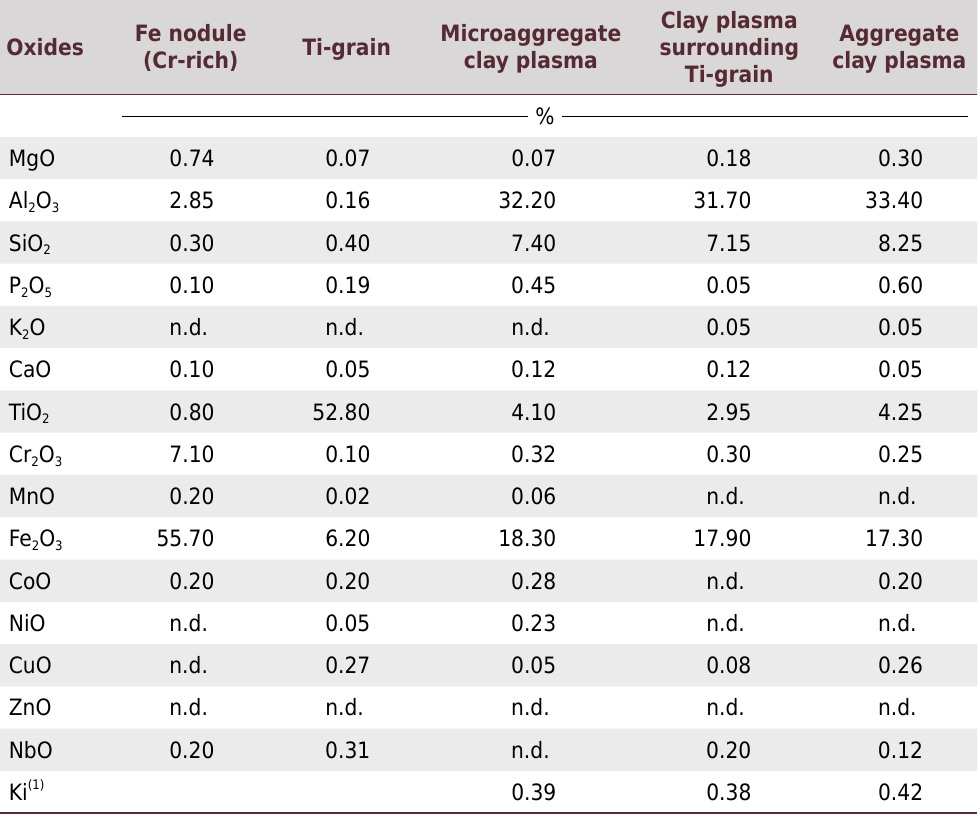
Table 5. The SEM-WDS microchemical analysis of selected pedofeatures of the Bw 2 horizon in the P 4 - Geric Acric Gibbsic Ferralsol (Clayic, Dystric); Patrocínio